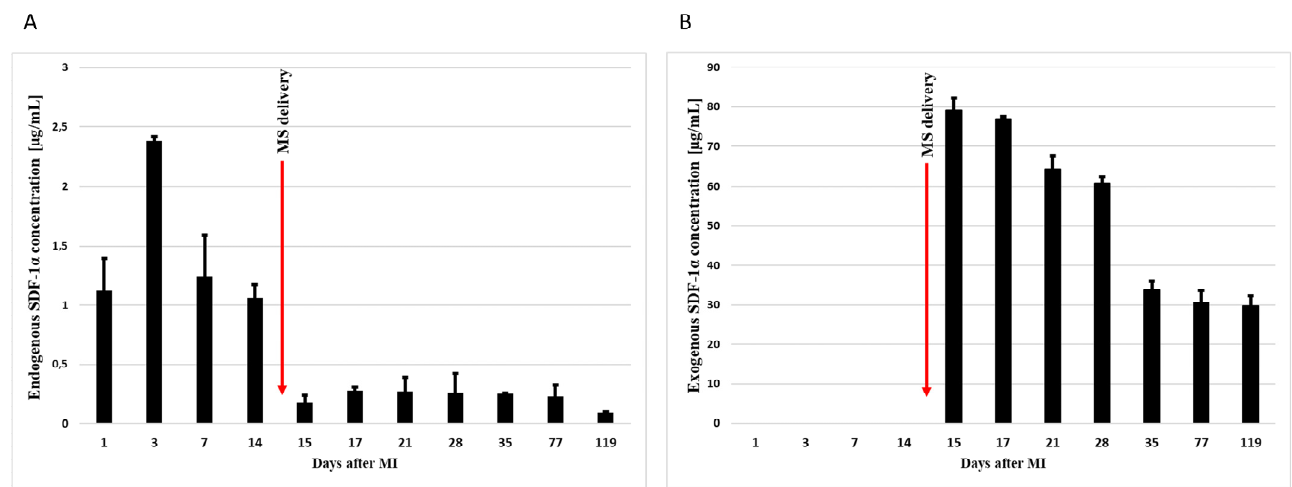
Figure 3. Concentration of endogenous ( A ) and exogenous ( B ) SDF-1 α in infarct tissue. Concentra- tions were measured by ELISA 1, 3, 7, 14, 15, 17, 21, 28, 35, 77, and 119 days after the myocardial infarction. In addition, 14 days after MI, SDF-1 α -released microspheres were transferred to the per- icardium sac. The bars represent the means ± SD ( n = 3).